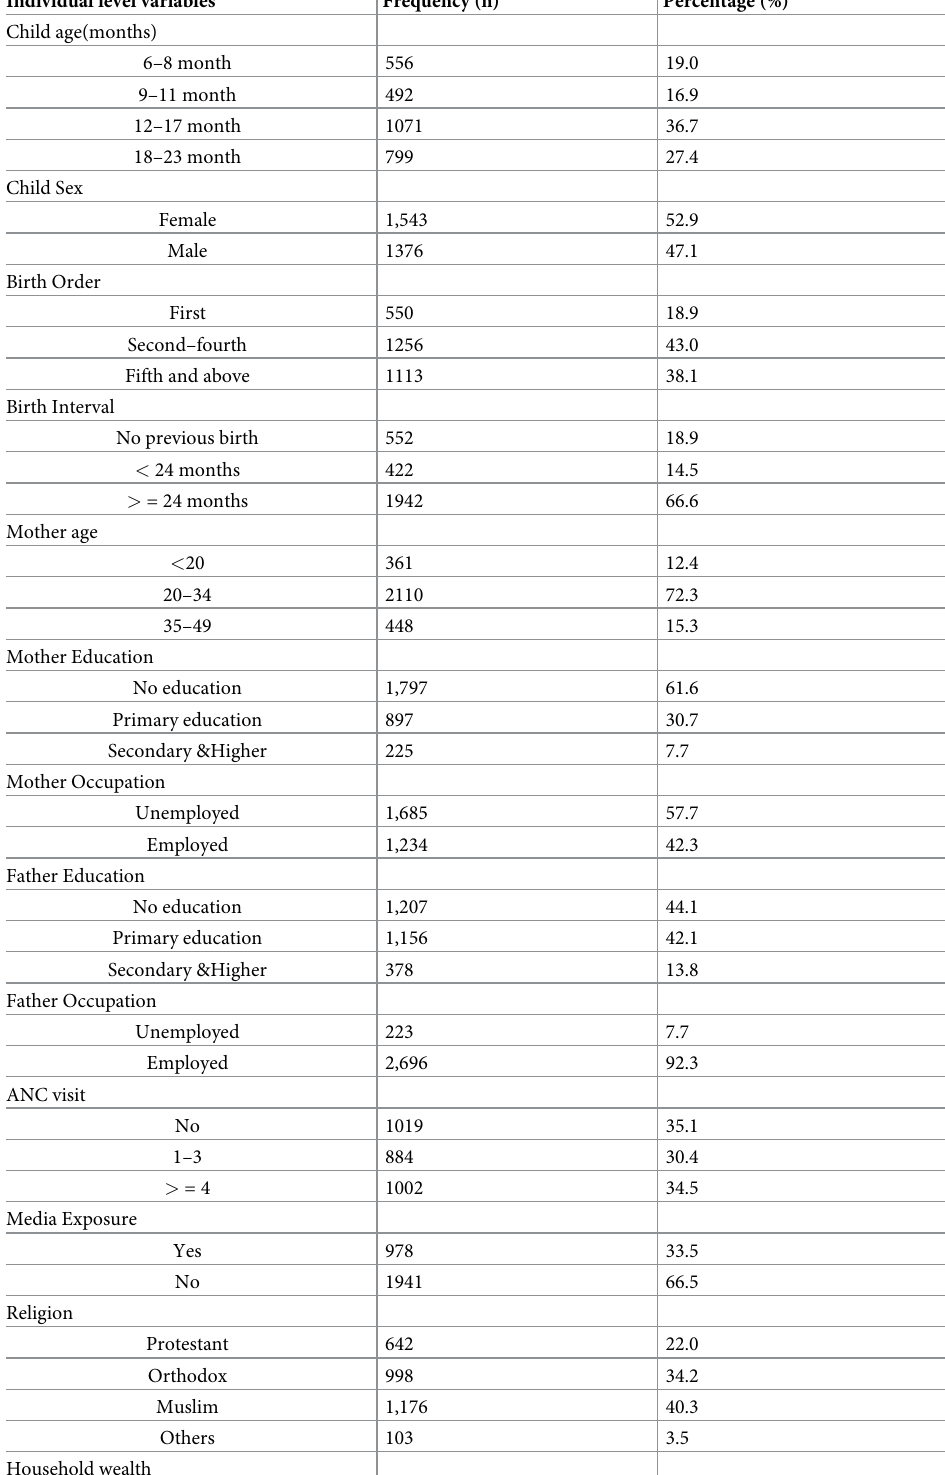
Table 2. The individual level characteristics of 6–23 months age children in Ethiopia, EDHS 2016(n =